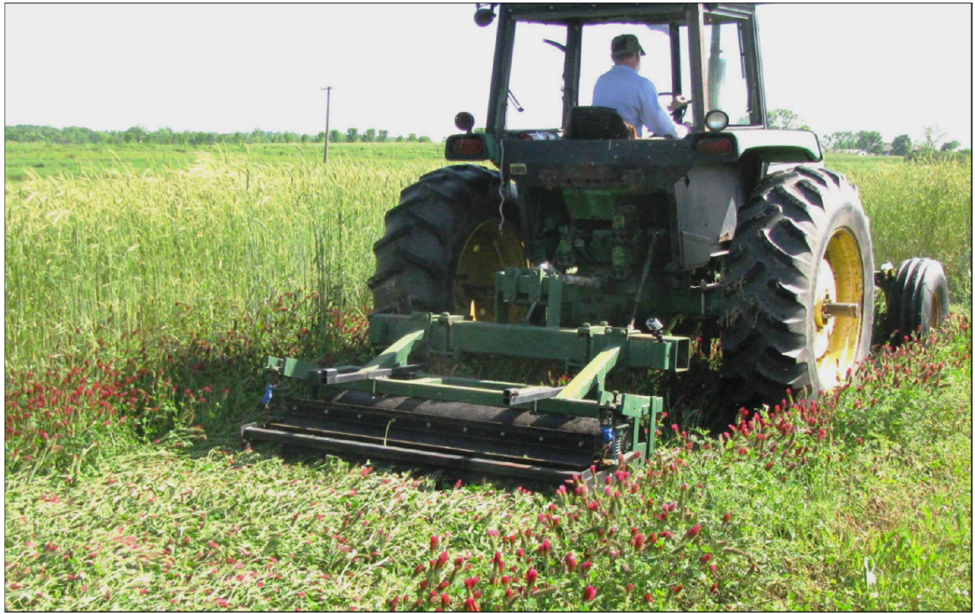
Figure 3. Two-stage roller-crimper (1.8 m wide) (Multistage crop roller. Kornecki, 2011, US patent #7987917 B1) in crimson clover [23].